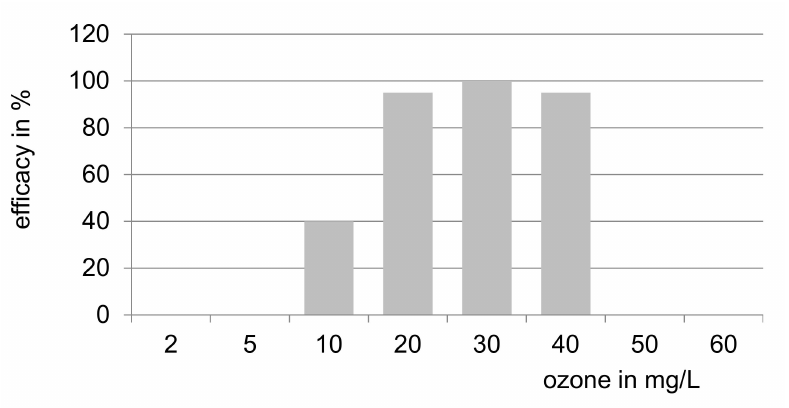
Figure 6. Dose response: efficacy–concentration relationship of systemically administered medical ozone as hormetic substance (schematically), modified after